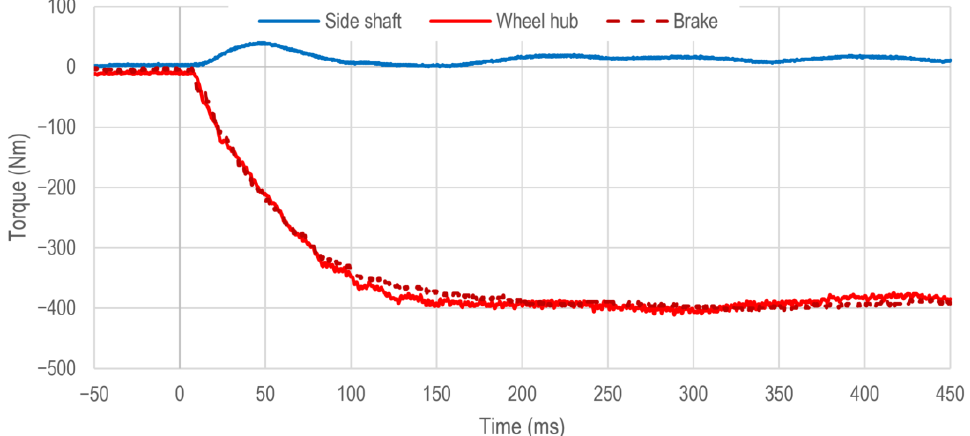
Figure 13. Braking operation with a conventional vehicle braking system from 25 km/h with activated anti-jerk control.